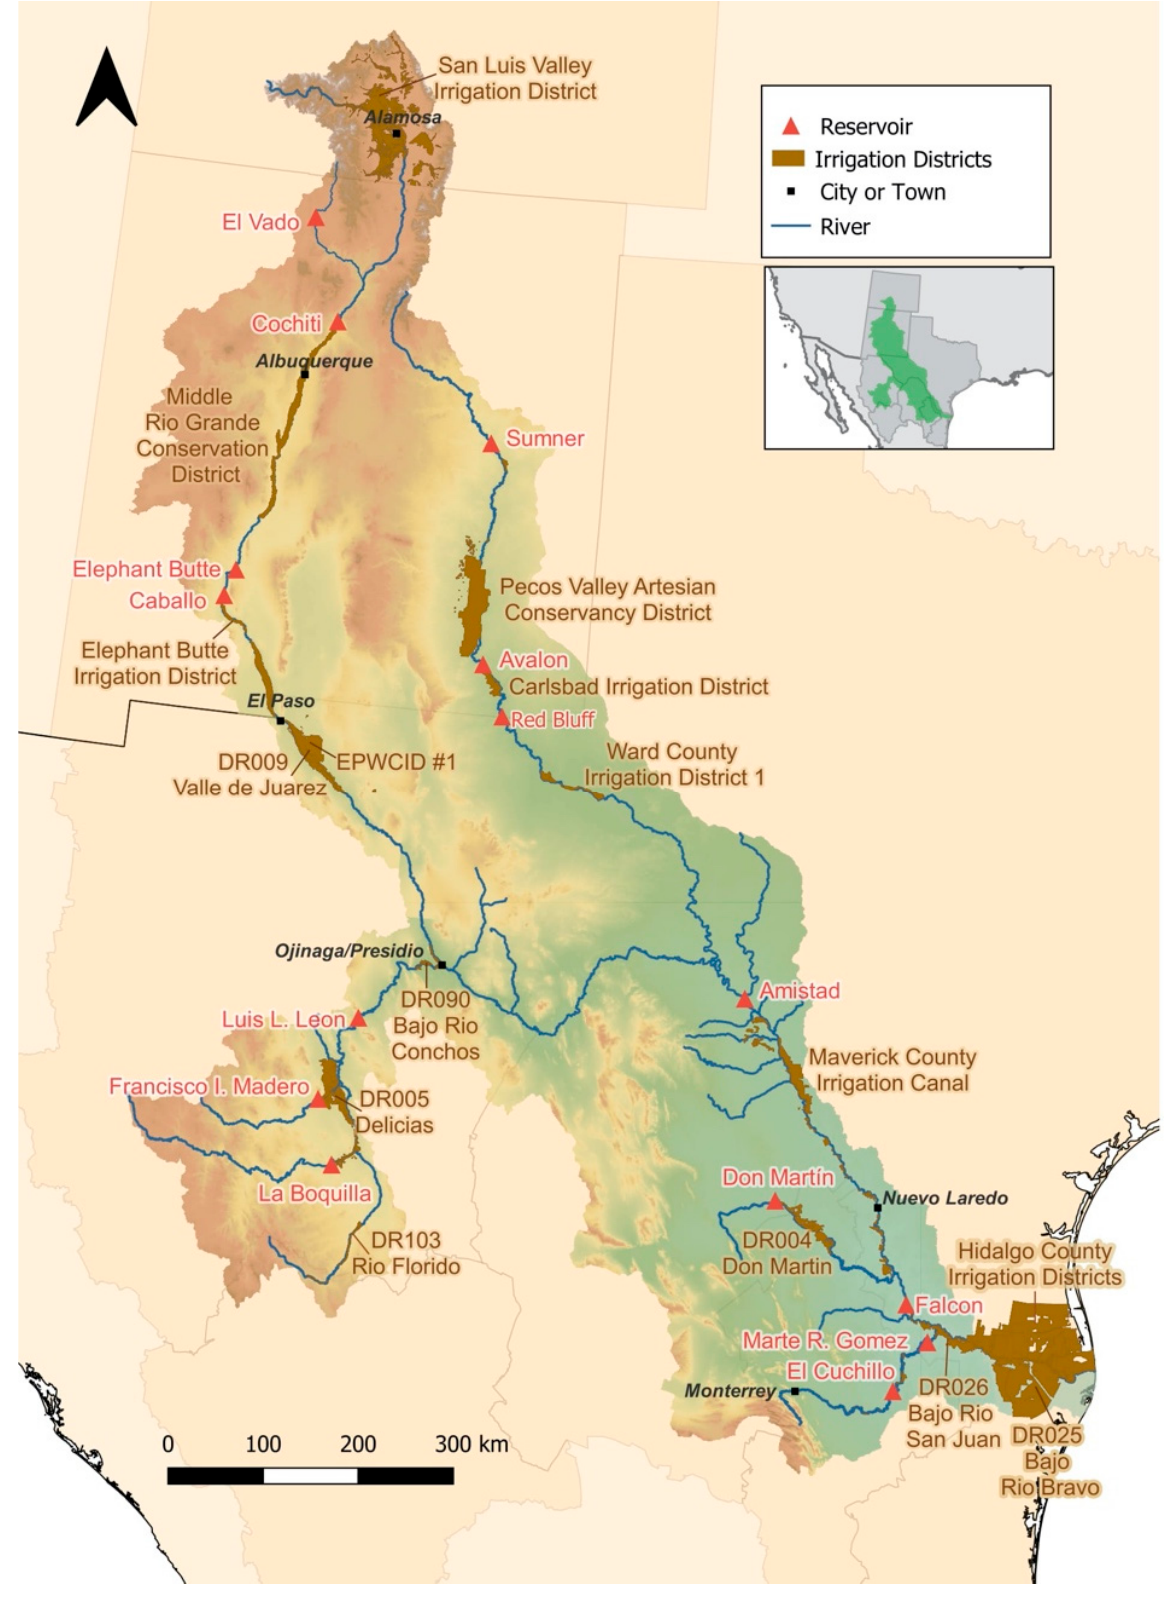
Figure 2. Irrigation districts, main cities, and reservoirs of the Rio Grande–Bravo basin.